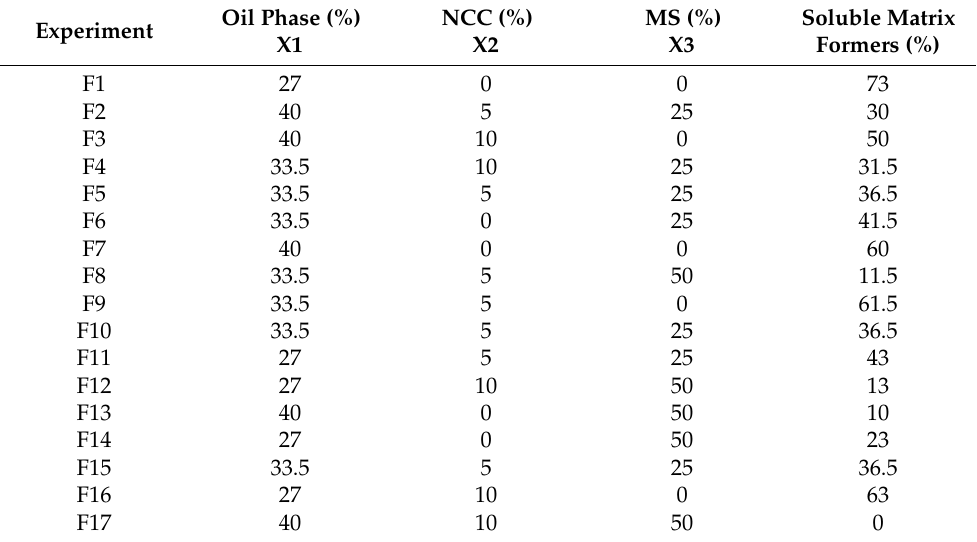
Table 1. Surface response experimental design, with three variables: oil phase (1-oleoyl-rac-glycerol with Miglyol ® 812—9:1, surfactant—Tween ® 20 * and simvastatin), NCC and MS (F1–F17). The oil phase percentage ranged from 27% to 40%, the NCC percentage ranged from 0% to 10% and the MS percentage ranged from 0% to